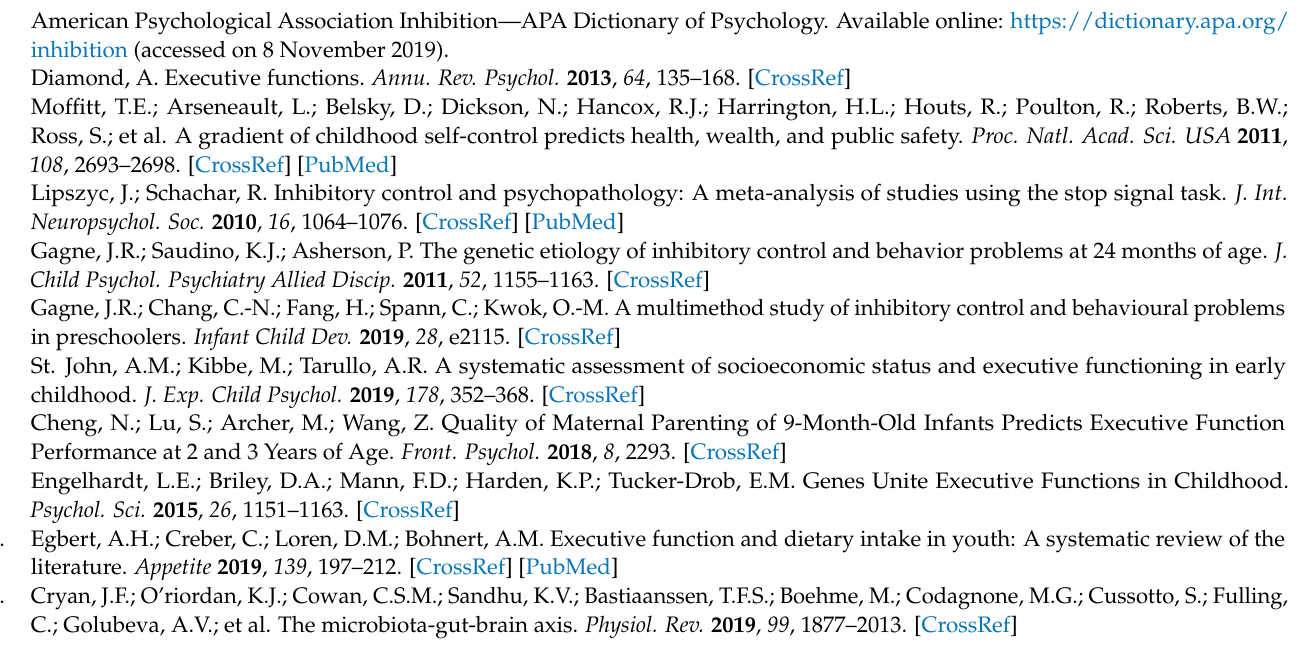
Table S5. Parameter Estimates and bootstrapped Confidence Intervals for Exploratory Models 9a, 10a, 11a, 12a, and 14a., Table S6. Parameter Estimates and bootstrapped Confidence Intervals for Exploratory Models 9b, 10b, 11b, 13b, and